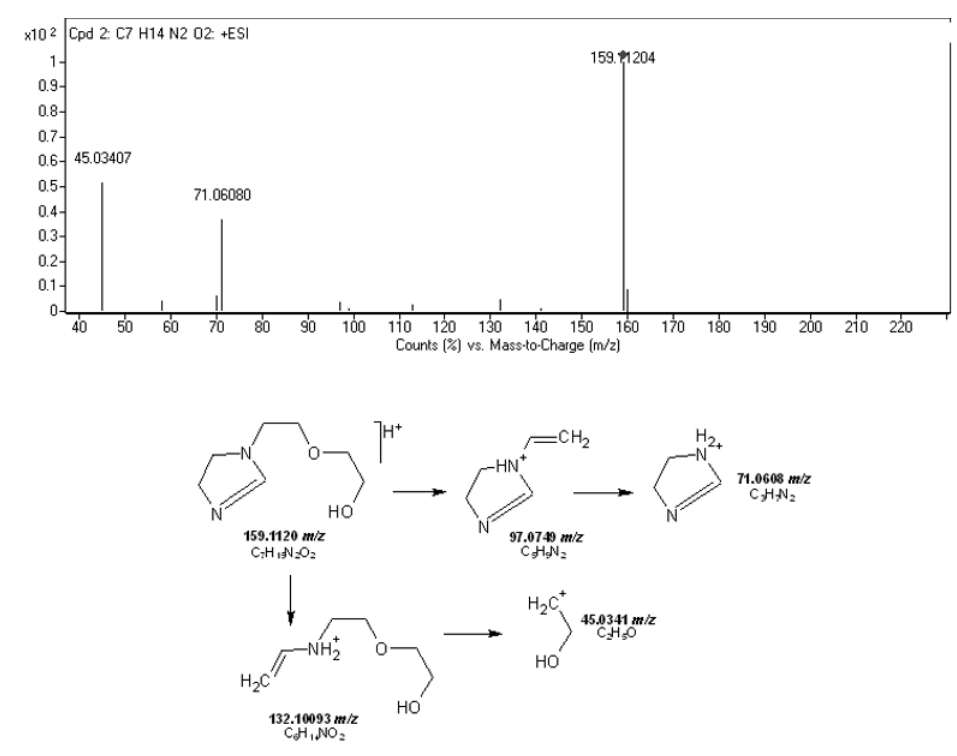
Figure 6. Q-TOF MS/MS spectrum and fragmentation pathway of photodegradation product D4 ( t